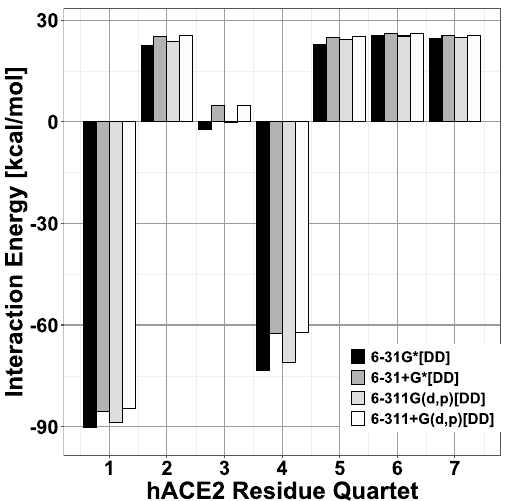
Figure 3. Interaction energies between hACE2 quartets and neighboring SARS-CoV-2 S-RBD residues. Interactions of repulsive (positive) and attractive (negative) character [kcal/mol] between hACE2 quartets and SARS-CoV-2 S-RBD residues within a 4.5 Å radius. For each quartet four adjacent vertical bars are shown corresponding to density functional calculations with 6-31G*, 6-31+G*, 6-311G(d,p) and 6-311+G(d,p) basis sets, respectively, plus additional van der Waals dispersion [DD] 22 corrections. Results from different basis sets are qualitatively similar. Quartet and supermolecular fragment coordinates used in calculations taken from PDB entry 6LZG.